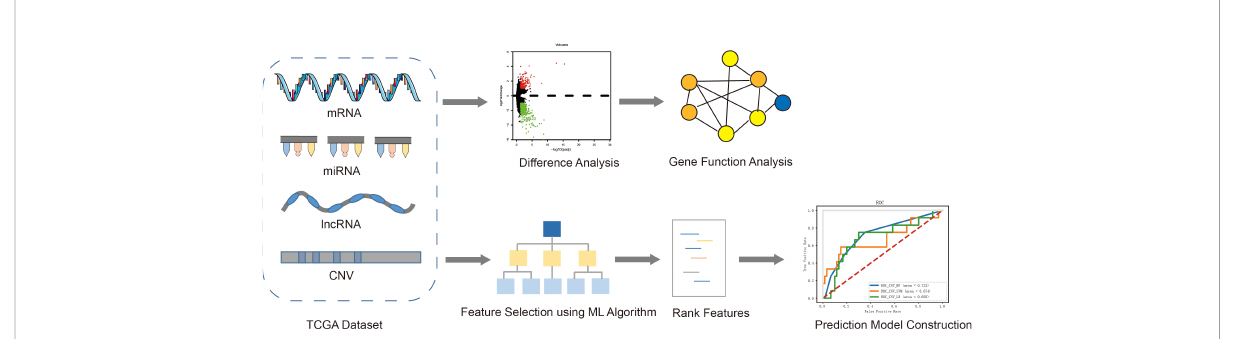
FIGURE 1 The overall pipeline of this study, including the following main steps: 1) Obtained four kinds of omics data (mRNA, miRNA, lncRNA and CNV) and clinical information of EC patients from TCGA; 2) Difference analysis between two groups and function analysis of differential genes; 3) Feature selection and construction of prediction